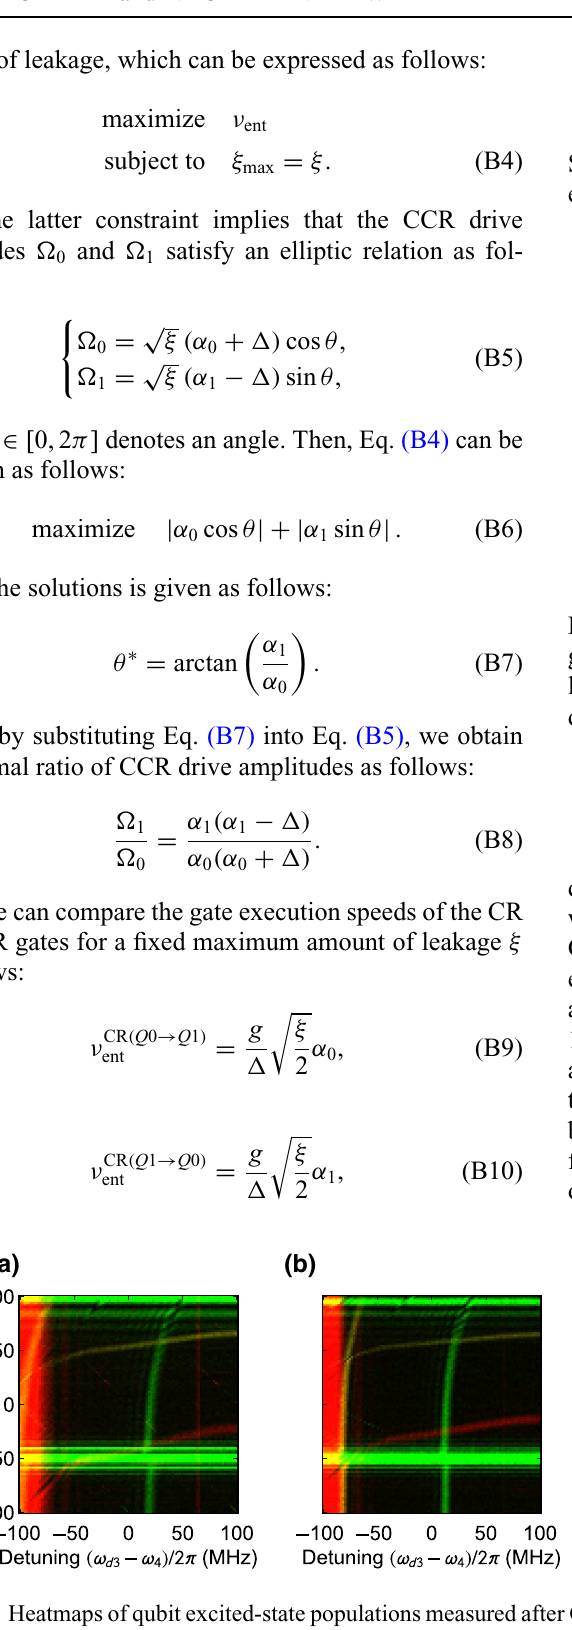
FIG. 5. Heatmaps of qubit excited-state populations measured after CCR gates with various frequency detunings from predetermined drive frequencies based on individual CR gate calibration. The measured populations of Q 3 and Q 4 are overlaid in the same plot. In each part, the vertical (horizontal) axis represents the detuning from the predetermined CR frequency of Q 4 ( Q 3), corresponding to the frequency of the target qubit Q 3 ( Q 4). The total duration of the R ZX (π/ 4 ) gate is set to (a) 145.8, (b) 168.0, and (c) 190.2